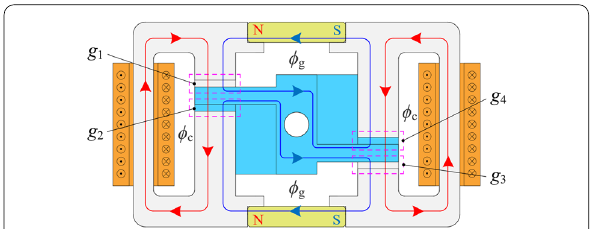
Figure 2 Magnetic circuit diagram of REMC-NFM